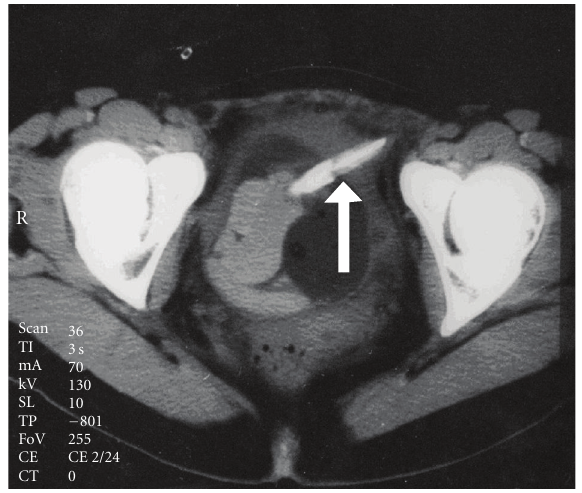
Figure 3: CT scan through the mid pelvis demonstrates a foreign body in urinary bladder which penetrates the right side (arrow).